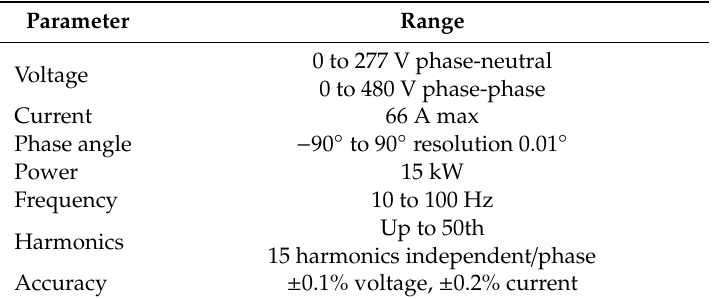
Table 3. Main features of electronic load, model Cinergia EL +